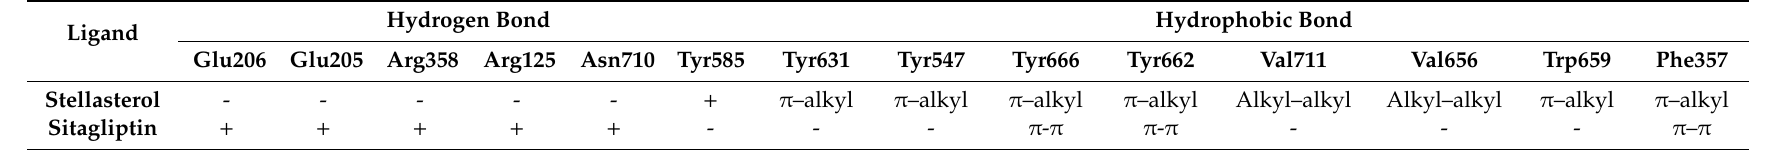
Table 1. Interaction of stellasterol and sitagliptin with the binding pocket of the human DPP-4 enzyme.